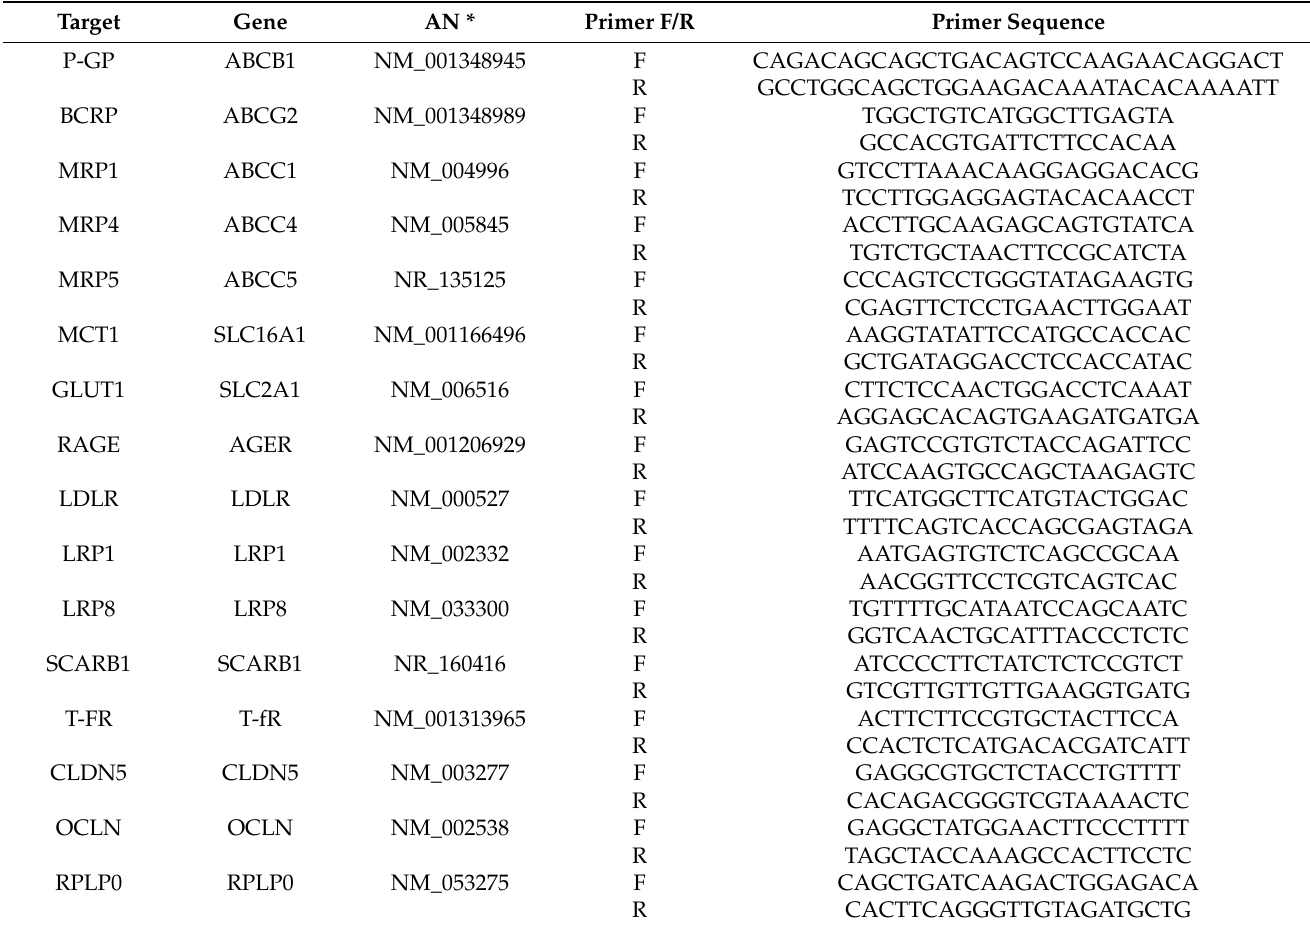
Table 1. Homo sapiens DNA primers used to amplify the mRNA expression of: efflux transporters such as P-glycoprotein (P-gp), breast cancer resistance protein (BCRP) and multidrug resistance proteins (MRPs; subfamily of the ATP-binding cassette (ABC) transporters); influx transporters such as Monocarboxylate transporter 1 (MCT1) and Glucose transporter 1 (GLUT1); large molecule receptors like the receptor for advanced glycation end products (RAGE), low-density lipoprotein receptor (LDLR) and related proteins (LRP1 and LRP8), Scavenger receptor class B type 1 (SCARB1) and transferrin receptor (T-RF), as well as junctional proteins Claudin-5 (CLDN5) and Occludin (OCLN): in the BLEC monolayer from the miniaturized and original in vitro BBB